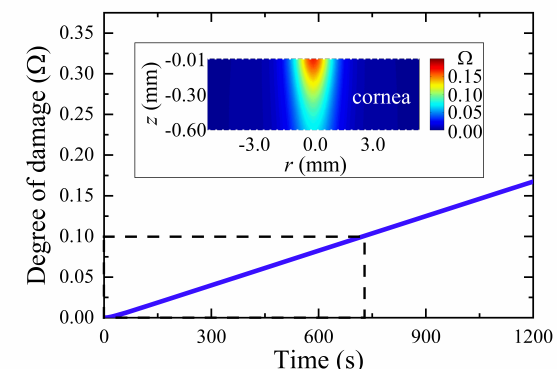
Figure 6. Time-dependent degree of damage at the top center of the cornea. The inset shows spatial distribution in the cornea at t = 1200 s. The results were calculated under THz radiation with a beam radius of w 0 = 3mm and power density of P d = 0.6W/cm 2